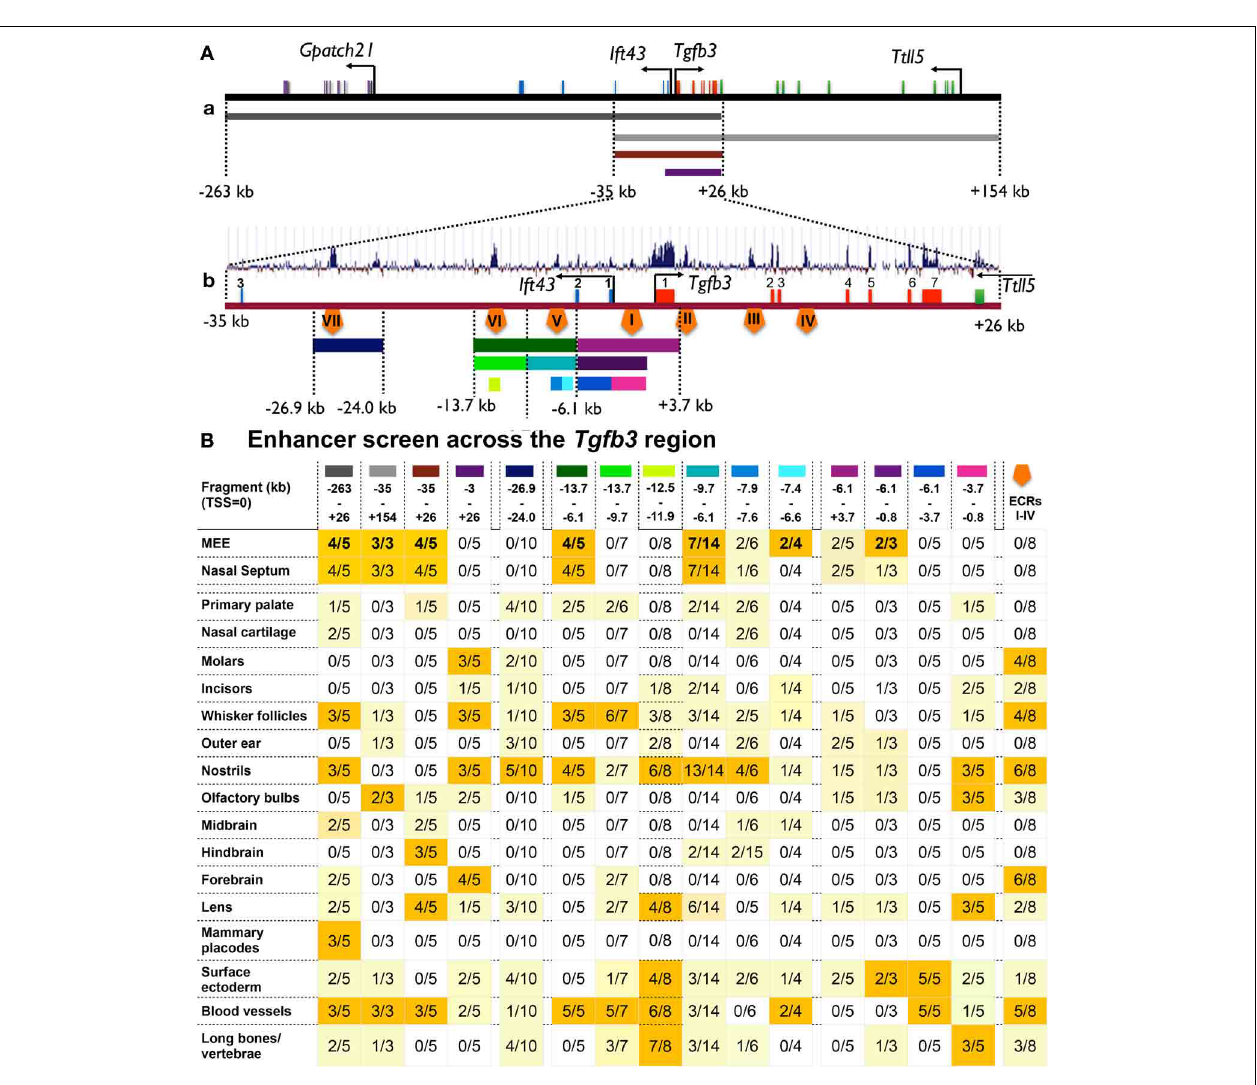
(UCSC genome browser) along this sequence. Orange pentagons indicate positions of ECRs I-VII (see main text); colored lines beneath correspond to the positions of regions used for regional expression regulation analysis (see B , fifth column onwards). (B) A table summarizing findings of reporter activity driven by the sequences in the regions indicated by colored bars in (A) in various tissues of transgenic embryos at E14. Data entries show the number of embryos displaying positive reporter activity in selected tissues (rows) over the total number of lacZ- positive embryos for each sequence (identified by a colored bar in each column); dark yellow highlight, 50% or more staining; pale yellow highlight, > 0%, < 50%